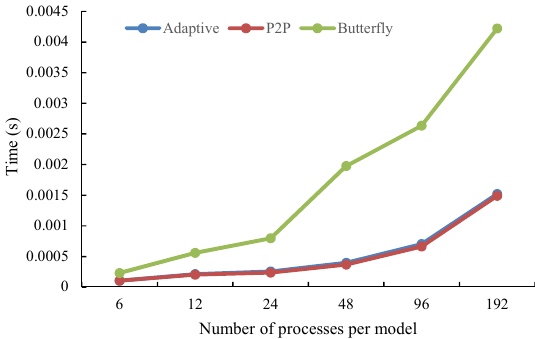
Figure 21. Average execution time ( y axis) of one data rearrange- ment for the parallel interpolation from the atmosphere grid (the grid size is 144 × 96 = 13824) to the ocean grid (the grid size is 320 × 384 = 122880) in CESM when varying the number of pro- cesses per model ( x axis).